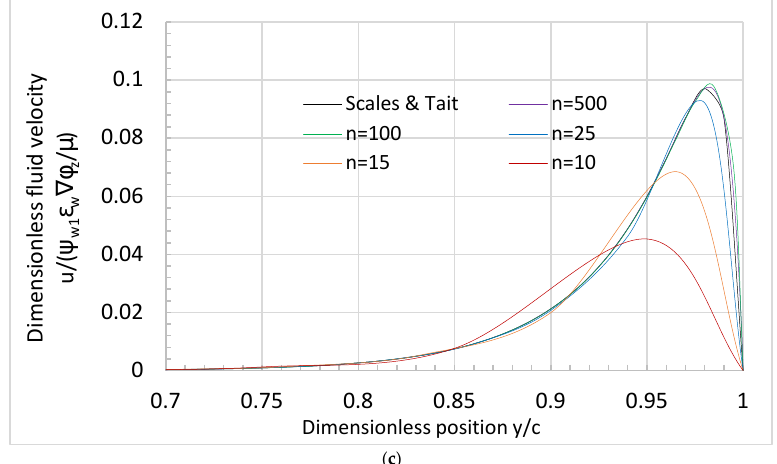
Figure 8. ( a ) Dimensionless velocity in a parallel plate channel. Single material. Uncharged medium with charged walls. ( b ) Dimensionless velocity in a parallel plate channel. Single material. Uncharged medium with charged walls. Detail in the vicinity of the charged wall ( ψ w1 = 0.03 V). ( c ) Dimensionless velocity in a parallel plate channel. Single material. Uncharged medium with charged walls. Detail in the vicinity of the charged wall ( ψ w2 = 0.01 V). Table 2. Fluid velocity and flow per unit section relative errors as a function of the number of cells. Parallel plate channel. Single material. Uncharged medium with charged walls.